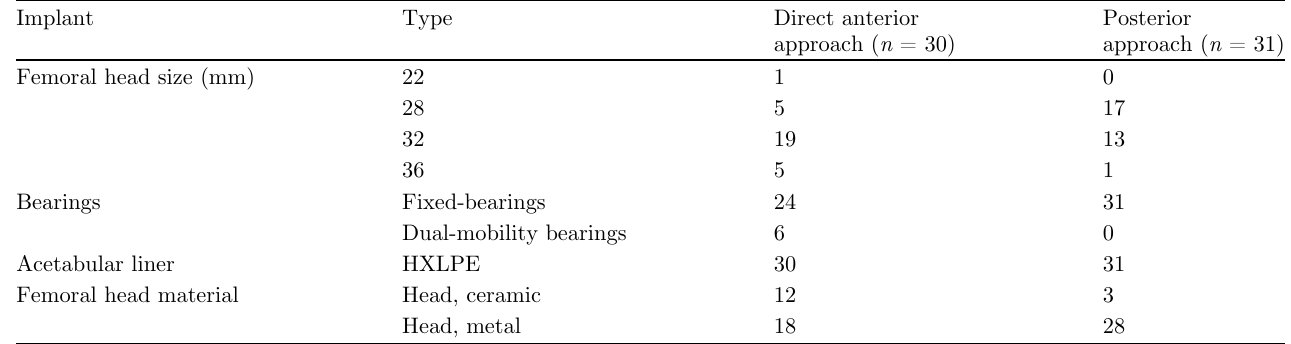
Table 2. Implants used in DAA and PA groups.